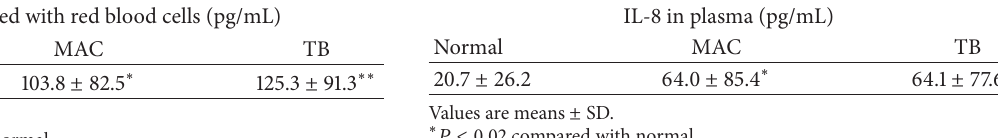
Table 2: Concentration of IL-8 (pg/mL) in human samples; A/ IL- 8 in human plasma from: normal subjects (7 subjects), patients infected with Mycobacterium Avium Complex (MAC, 13 patients), and patients infected with TB (14 patients).